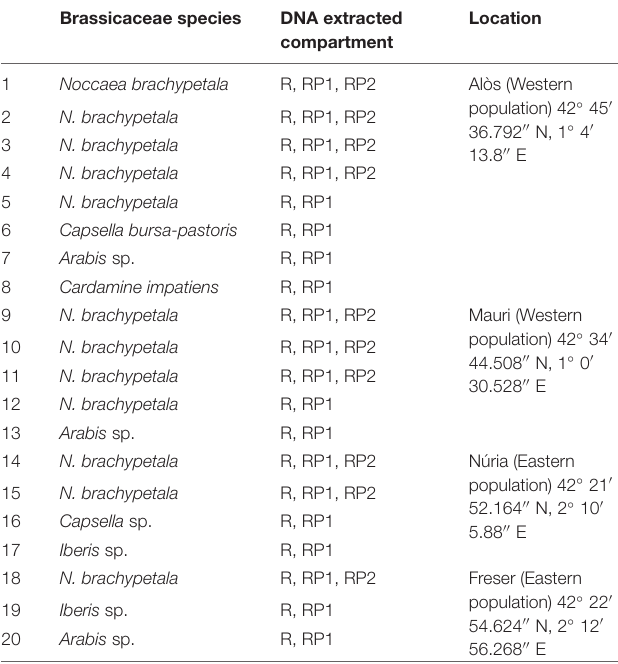
TABLE 1 | Sampled plants for the rhizosphere microbioma sequencing. Brassicaceae species DNA extracted compartment